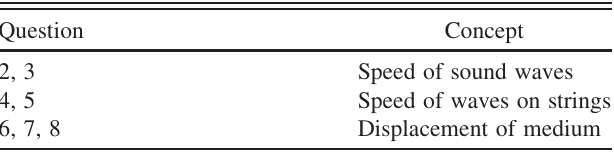
TABLE I. Concepts covered in the survey on the subtopic of